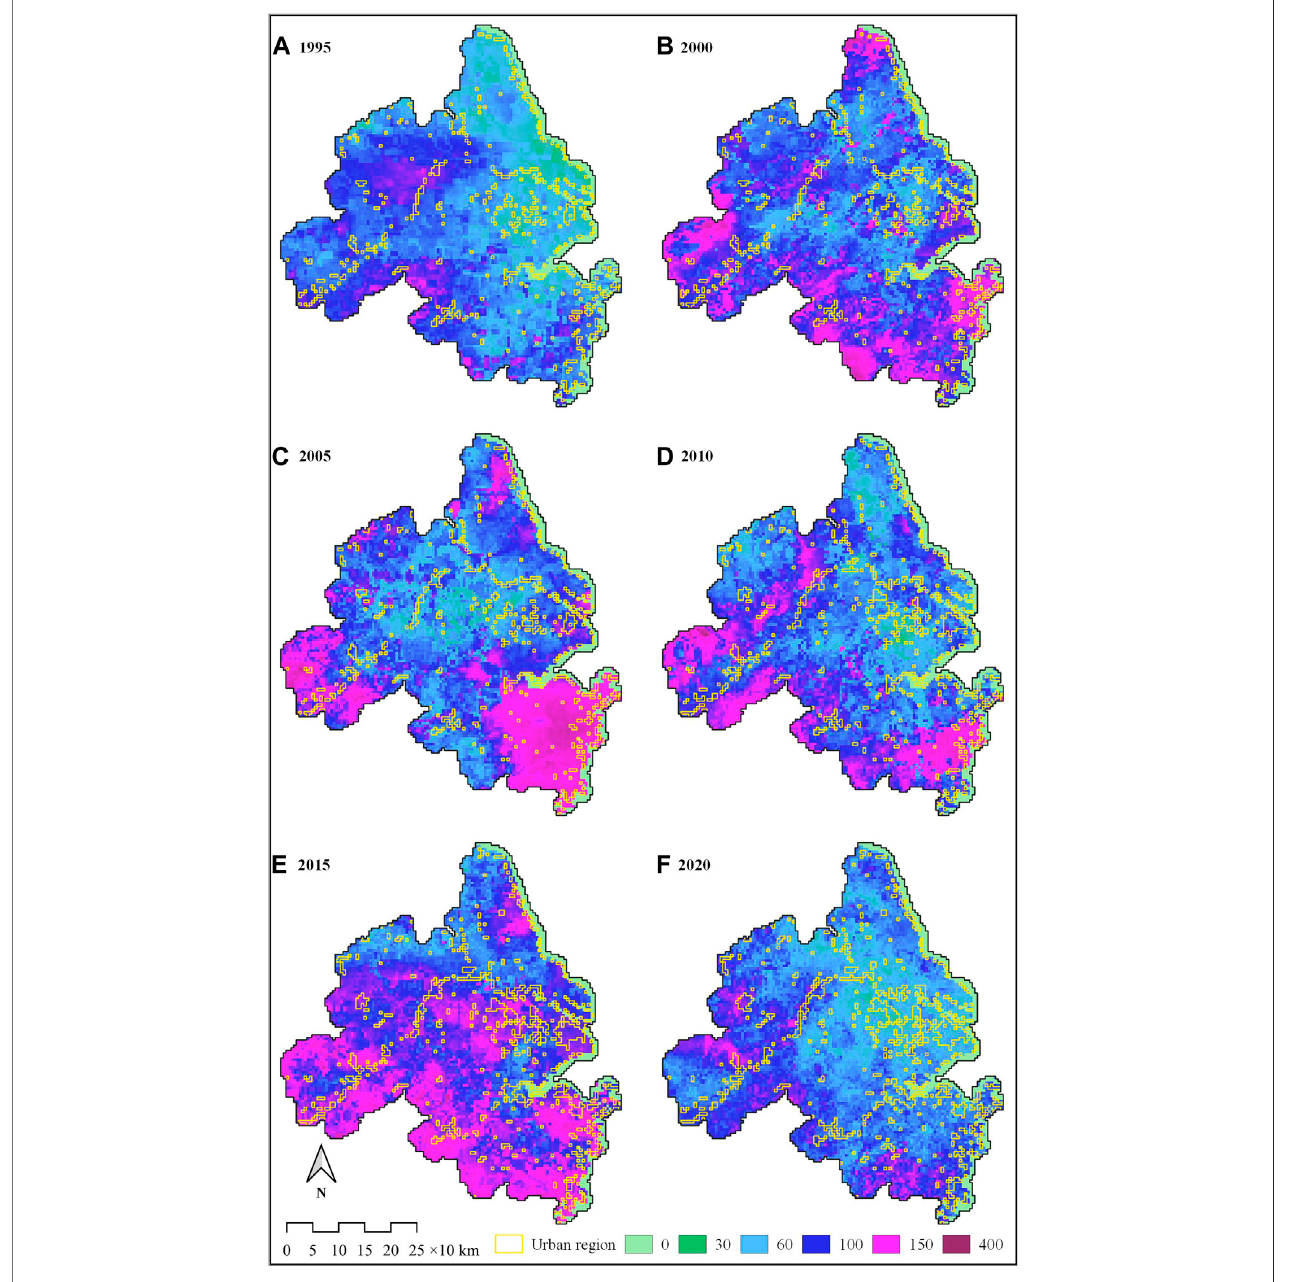
FIGURE 5 | The distribution of annual MDP in the YDM at quinquennial intervals from 1995 to 2020.